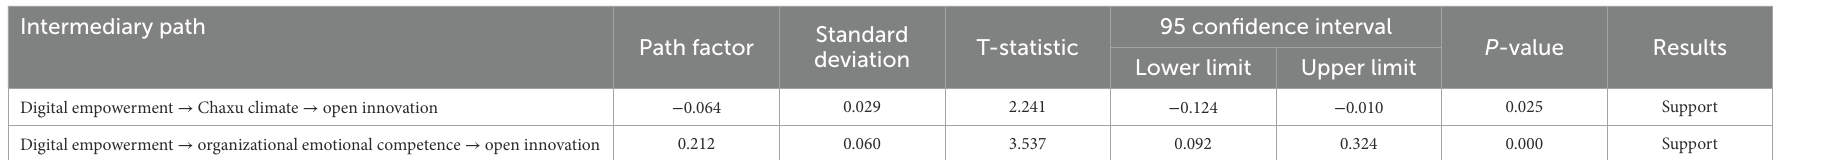
TABLE 6 Significance tests for mediating effects.